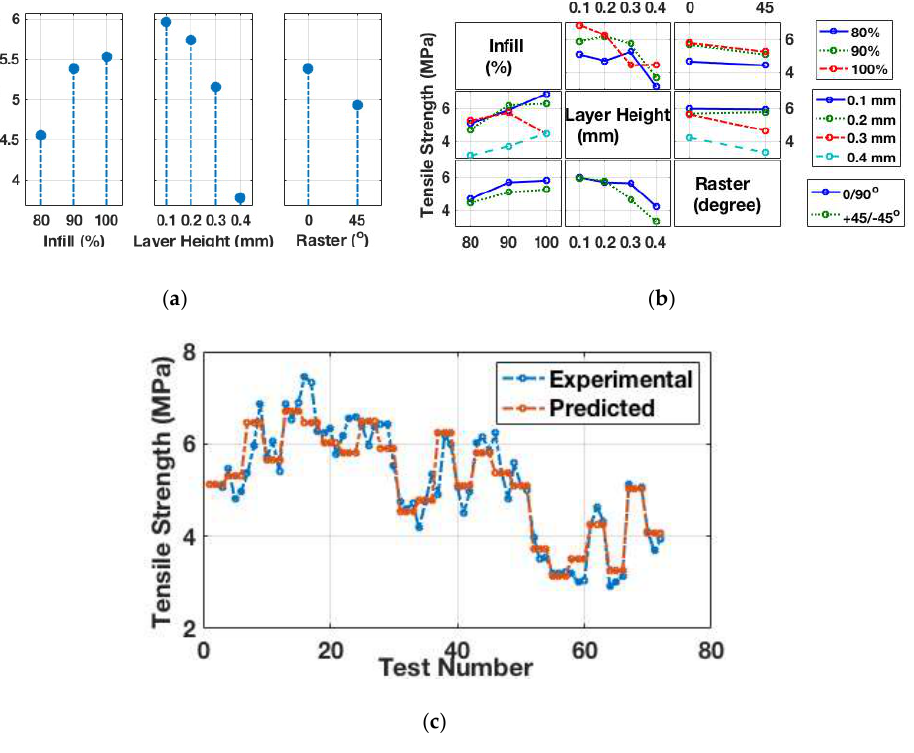
Figure 5. ( a ) Main effect plot of each factor for the quasi-static tensile tests. ( b ) Interaction plot for quasi-static tensile test results. ( c ) Experimental versus predicted tensile strength.